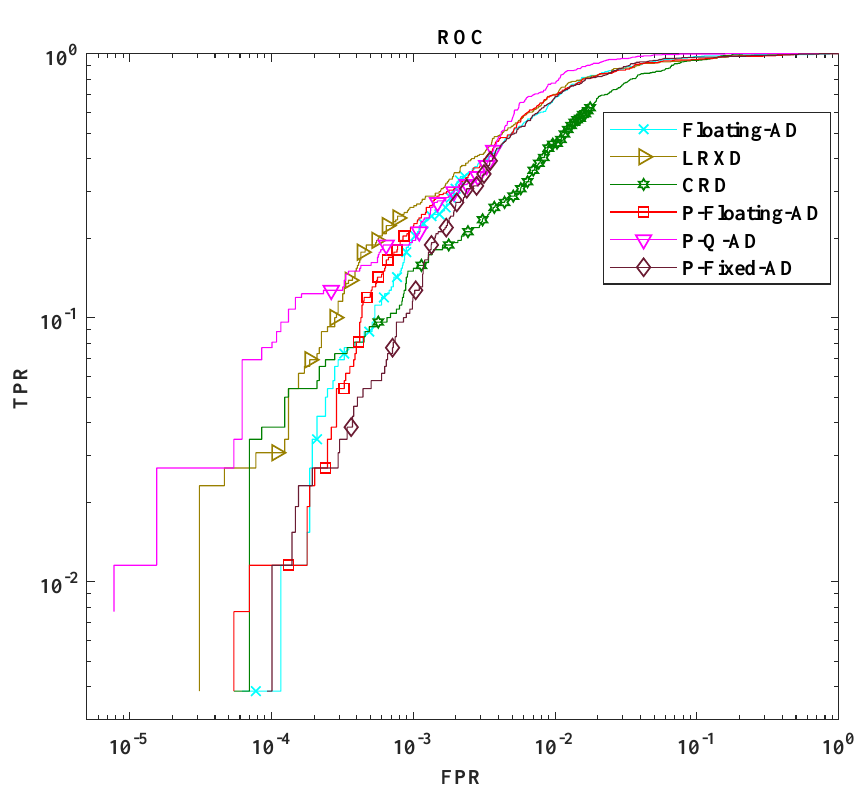
Figure 22. The ROC curve for the Los Angeles data set. Table 7. The AUC value and the detection time consumption of Los Angeles data